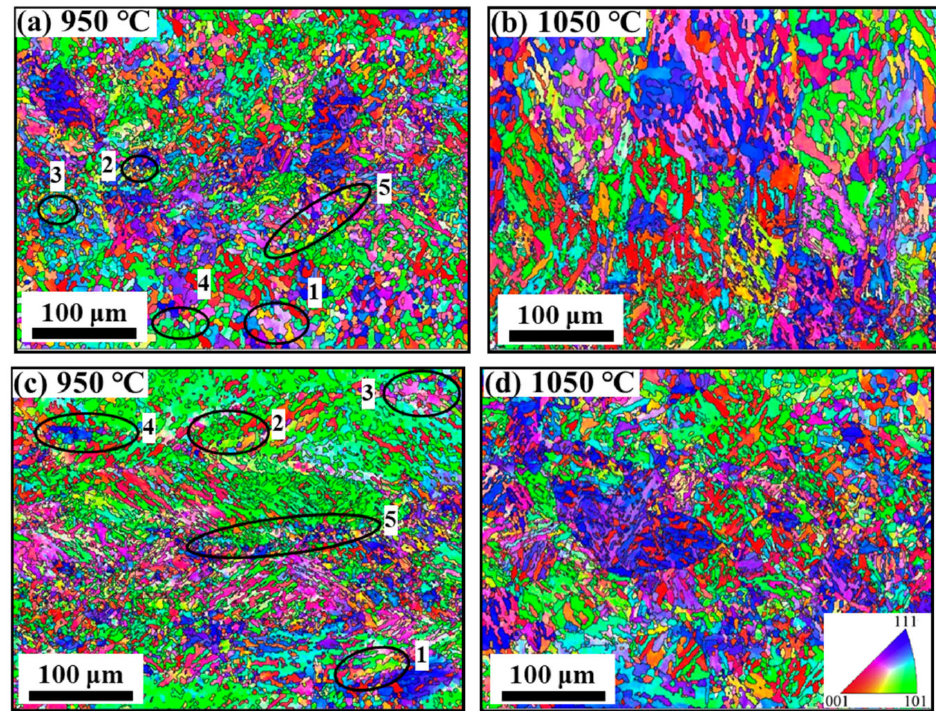
Figure 9. IPF maps of samples deformed at 0.1 s − 1 at different deformation temperatures of ( a ) without ultrasonic 950 ◦ C, ( b ) without ultrasonic 1050 ◦ C, ( c ) with ultrasonic 950 ◦ C, ( d ) with ultrasonic 1050 ◦